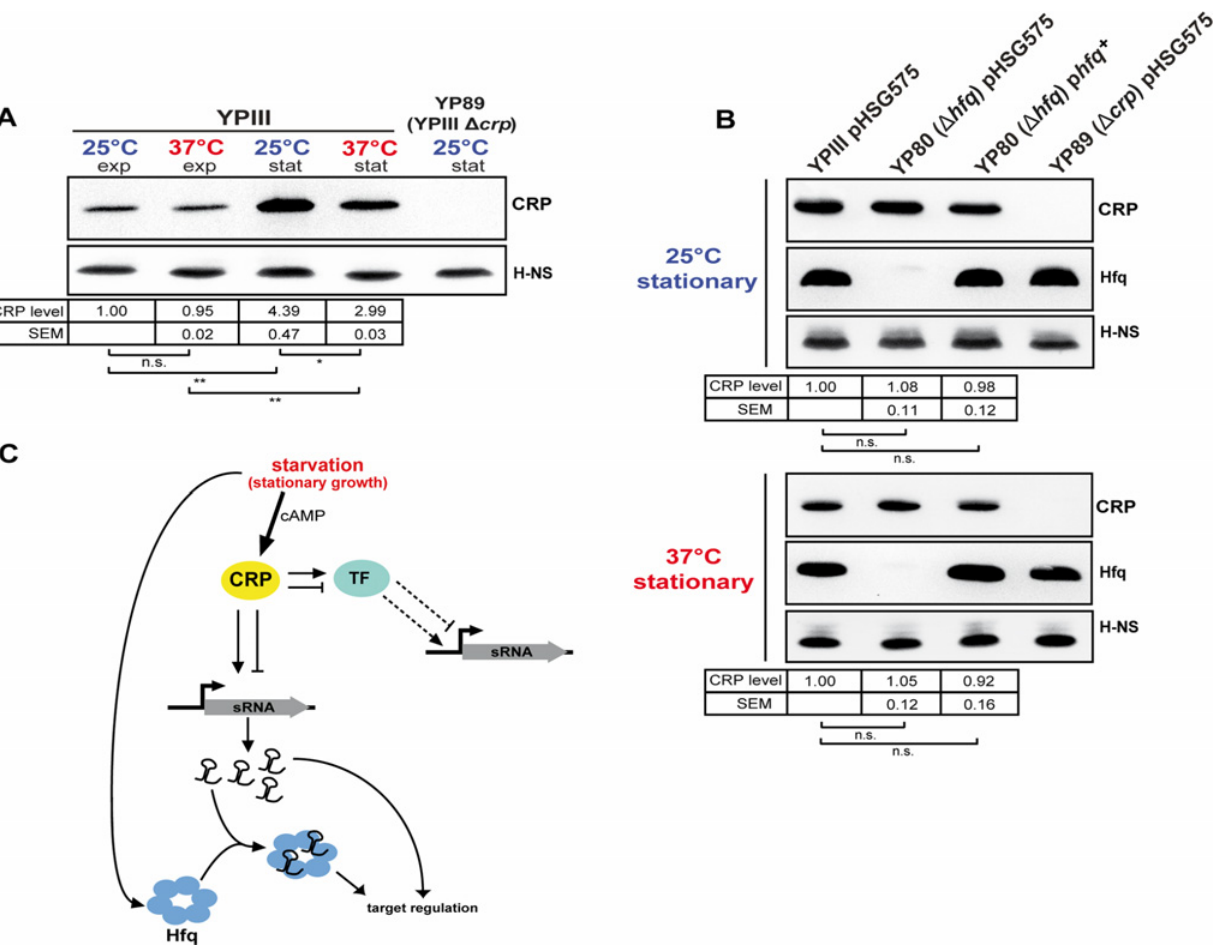
Fig 6. CRP, a growth phase and temperature-responsive master regulator in Y. pseudotuberculosis . (A) CRP protein levels in response to growth phase and temperature. Equal amounts of whole cell extracts of YPIII grown to exponential (exp) or stationary phase (stat) at 25°C and 37°C were separated by SDS-PAGE prior to Western blotting using polyclonal CRP antibodies. H-NS served as loading control. YP89 (YPIII Δ crp ) was included as negative control. Relative protein amounts were quantified using ImageJ. The data represent the mean ± SEM from three independent experiments analyzed with Student ’ s t-test. * : P < 0,05; ** : P < 0,01; n.s.: not significant. (B) Effect of the RNA chaperone Hfq on CRP. Equal amounts of whole cell extracts of the wild- type strain YPIII, the isogenic hfq mutant (YP80) and the complemented hfq mutant (YPIII pBW131 (p hfq +)) grown to stationary phase at 25°C and 37°C were separated by SDS-PAGE prior to Western blotting using polyclonal CRP or Hfq antibodies. Plasmid pHSG575 served as the empty vector control. YP89 (YPIII Δ crp ) was included as negative control. H-NS served as loading control. Relative protein amounts were quantified using ImageJ. The data represent the mean ± SEM from three independent experiments analyzed with Student ’ s t-test. n.s.: not significant. (C) Current model of growth phase- and temperature-dependent sRNA expression involving the transcriptional regulator CRP and the RNA chaperone Hfq. During stationary growth when glucose is limiting intracellular CRP and cAMP levels increase, leading to accumulation of active CRP protein. Active CRP induces the expression of numerous sRNAs by direct binding to the regulatory region of the sRNA gene, thereby stimulating or repressing transcription. Further, expression of those sRNAs which are not directly regulated by CRP might involve one or more of the CRP-dependent transcription factors (TF), whose expression is differently affected by temperature. During stationary growth the RNA chaperone Hfq accumulates, similar to CRP, and affects sRNA abundance on the post-transcriptional